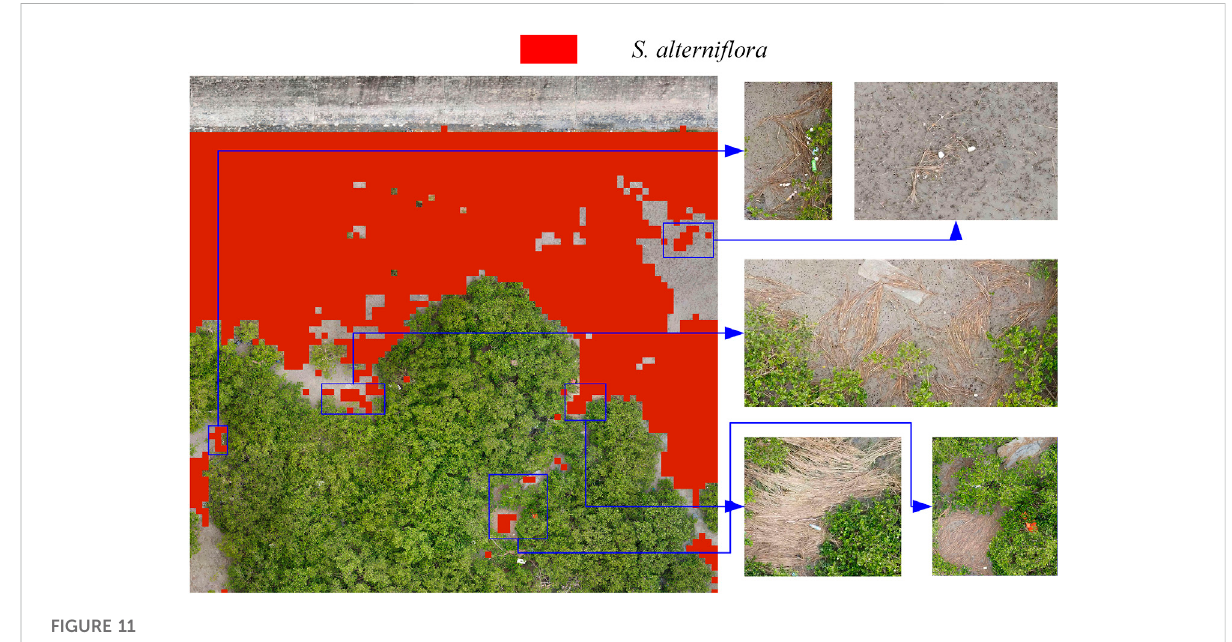
FIGURE 11 The A2 model misidenti fi es hay as S. alterni fl ora in spring.